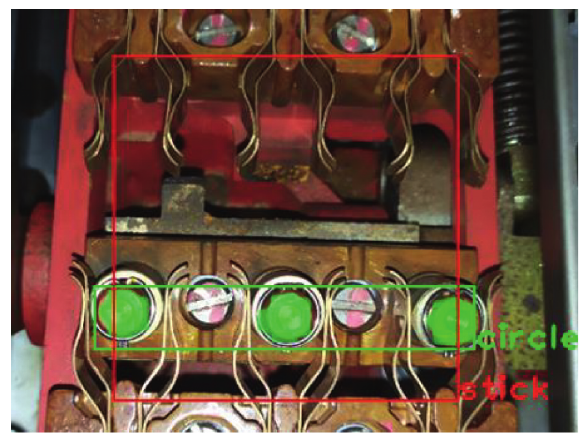
Figure 8: The single-layer Mask R-CNN positioning